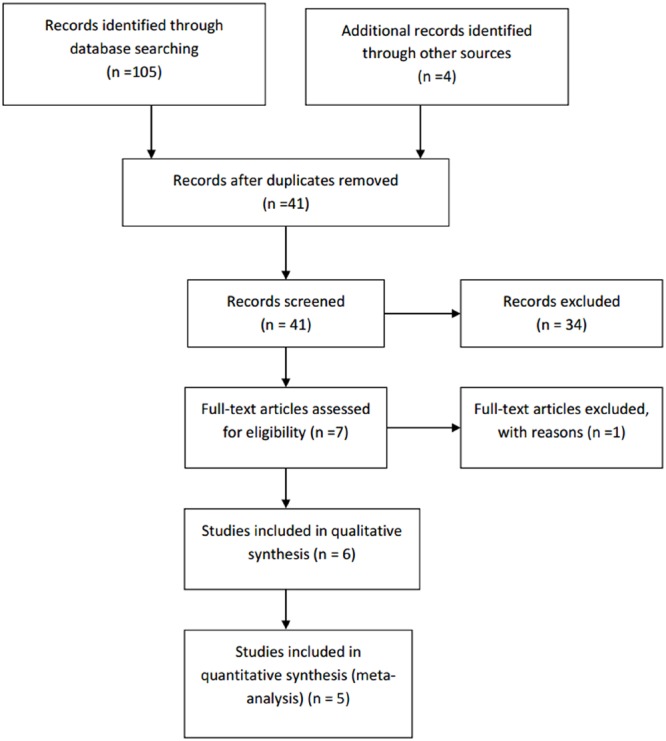
PRISMA flow chart.